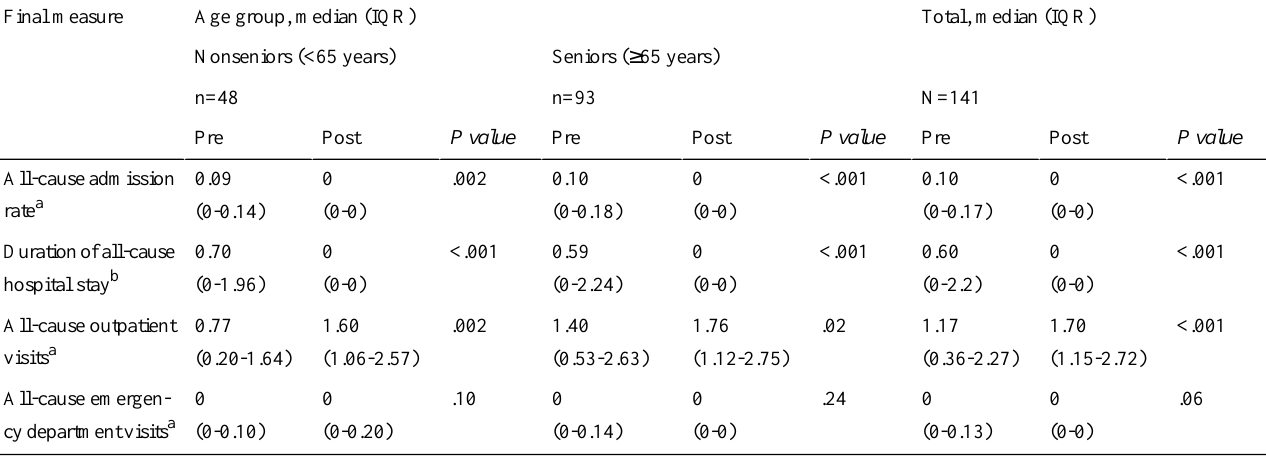
Table 2. Differences in admission rates and duration of hospital stays 6 months before (pre) and 6 months after (post) initiation of telehealth services in patients with cardiovascular diseases, stratified according to age.